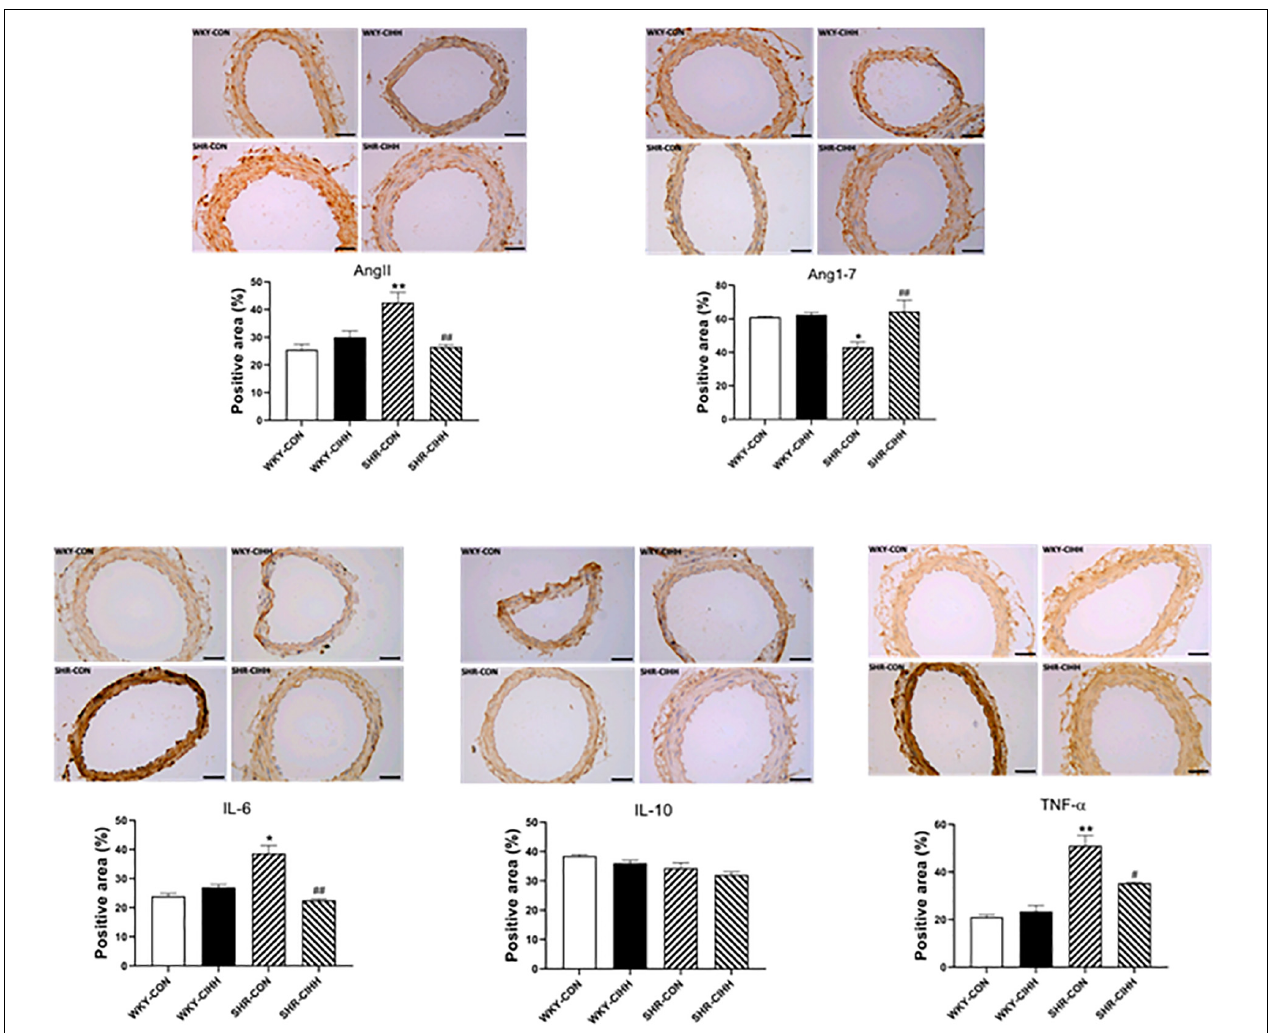
FIGURE 4 | Effect of chronic intermittent hypobaric hypoxia (CIHH) on angiotensin II (Ang II), angiotensin 1–7 (Ang1–7), IL-6, TNF- α , and IL-10 in mesenteric arteries of spontaneously hypertensive rats (SHRs). Data are expressed as mean ± SEM; n = 5 for each group. SHR-CON: control SHR; SHR-CIHH: SHR with CIHH; WKY-CON: control WKY rats; WKY-CIHH: WKY rats with CIHH; * P < 0.05, ** P < 0.01 vs. WKY-CON, # P < 0.05, ## P < 0.01 vs. SHR-CON (one-way